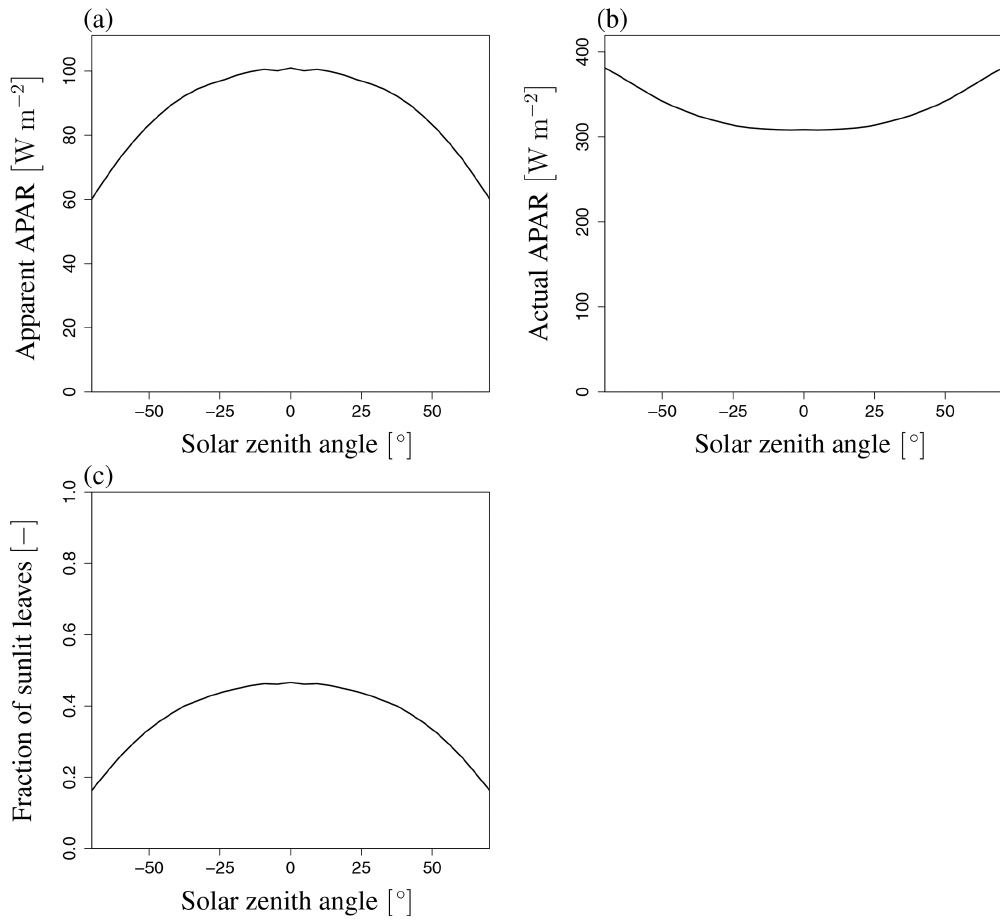
Figure 13. Variation of apparent and actual APAR and fraction of sunlit leaves with SZA. (a) Apparent APAR (APAR app ), (b) actual APAR (APAR c ), and (c) fraction of sunlit leaves (F sun ) at LAI of 3.0. These variables are not affected by VZA. APAR app and F sun decrease and APAR c increases with an increase in | SZA |